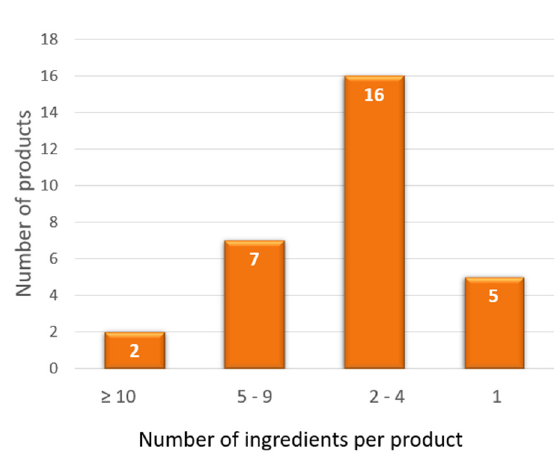
Figure 3. Number of ingredients per product contained in 30 preparations available on the market and claiming to treat kidney stones. The graph shows that the number of ingredients is variable, from only 1 to 16 components.